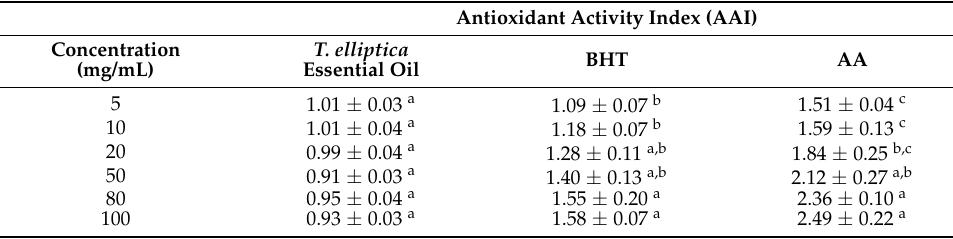
Table 4. Antioxidant activity of T. elliptica essential oil measured by Rancimat